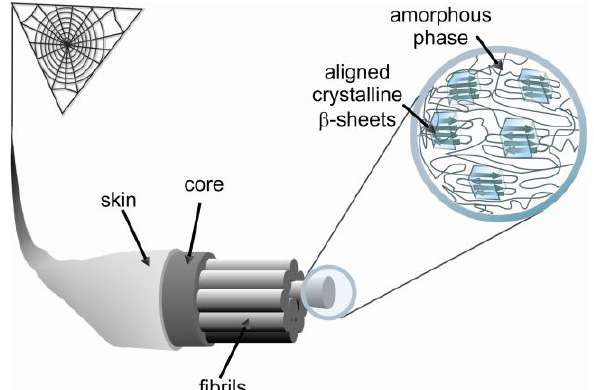
Figure 1. Schematic representation of the hierarchical structure of a spider MA silk fiber. On the macroscopic level, the skin-core structure can be recognized [106] and on the sub-microscopic level, the presence of the aligned fibrils has been shown [107]. The nanoscopic structure is represented by poly-Ala  -sheet crystals aligned with the fiber axis and embedded in the amorphous phase, comprising GPGXX and GGX ensemble repeats